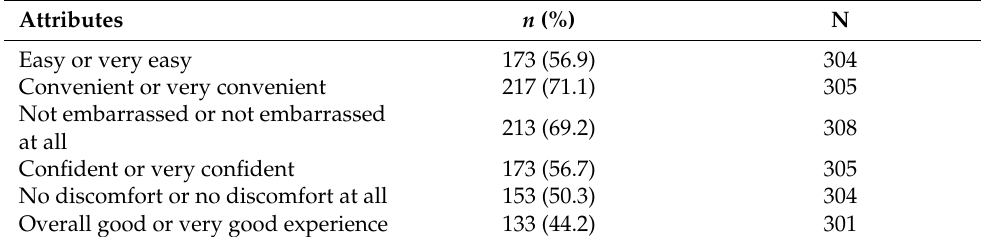
Table 4. Acceptability for all women who had self-sampling (N =